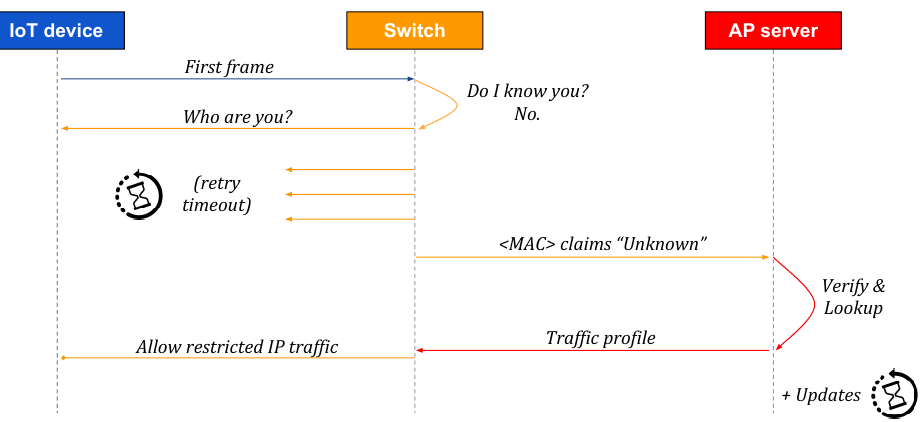
Figure 3. Sequence of messages: a non-conforming IoT device connects to an Autopolicy network. The switch synthesizes an "Unknown" identity, and sends it to the Autopolicy server (AP server), Autopolicy: Identification (switch cache) which replies with a generic traffic profile that restricts network resource usage.